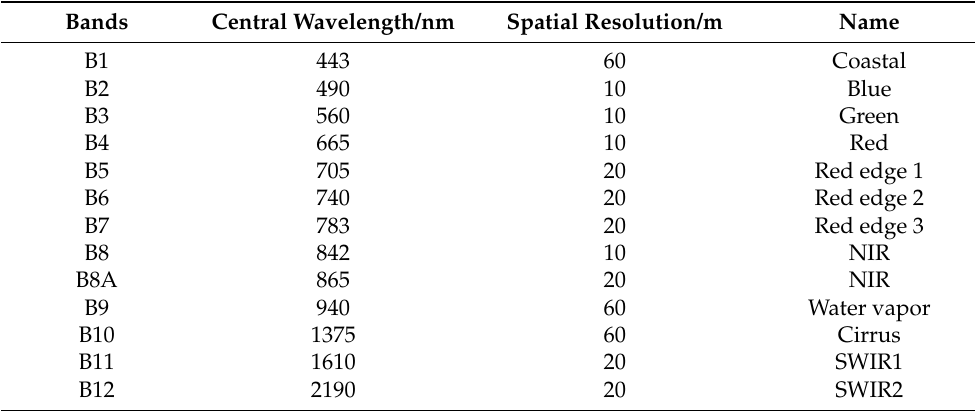
Table 1. Band information of the Sentinel-2